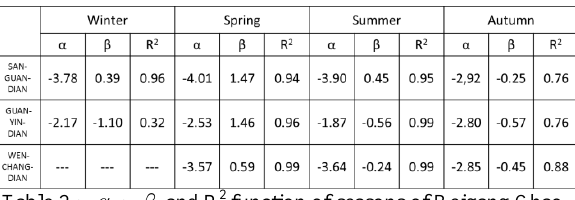
Figure 8 、 High position sensor of position in Beigang Chao- Tian Temple